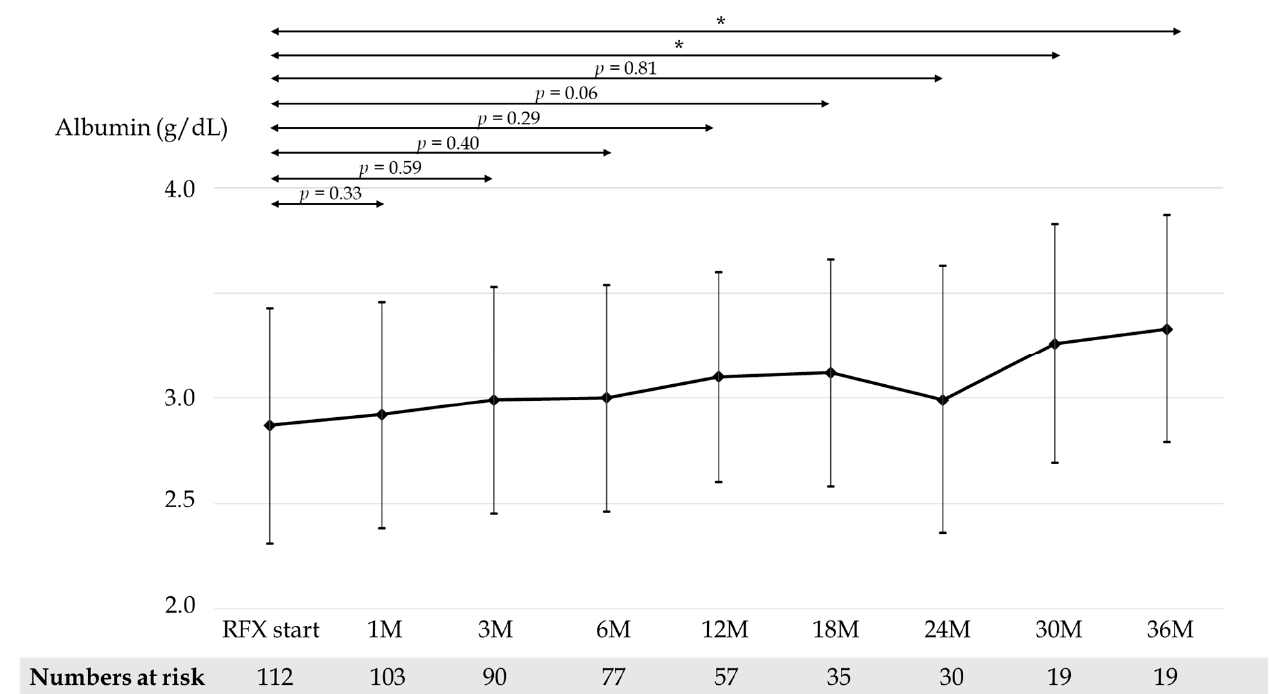
Figure 4. Changes in mean serum albumin concentration before and 1, 3, 6, 12, 18, 24, 30, and 36 months after RFX administration. p -values were determined using the Wilcoxon signed-rank test ( p < 0.1 tendency differences, p < 0.05 *). RFX, rifaximin.